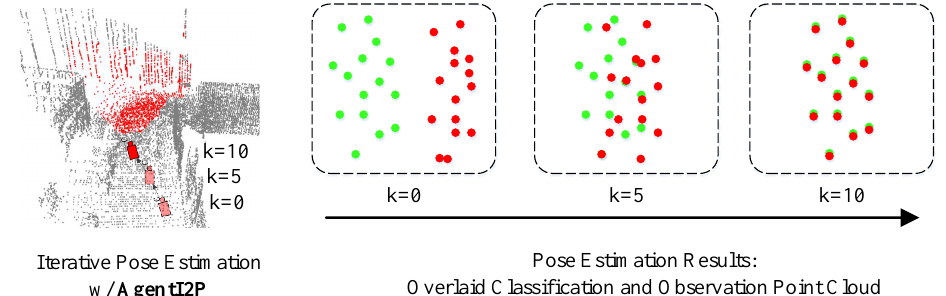
Figure 1. The basic insight of our method. The left figure shows the classification point cloud (green) from a pre-trained network. The middle figure shows the trajectory of estimated poses and the observation point cloud (red) in AgentI2P’s iterative pose estimation procedure. The right figure shows the observation point cloud (red) is aligned to the classification point cloud (green) along with several camera pose